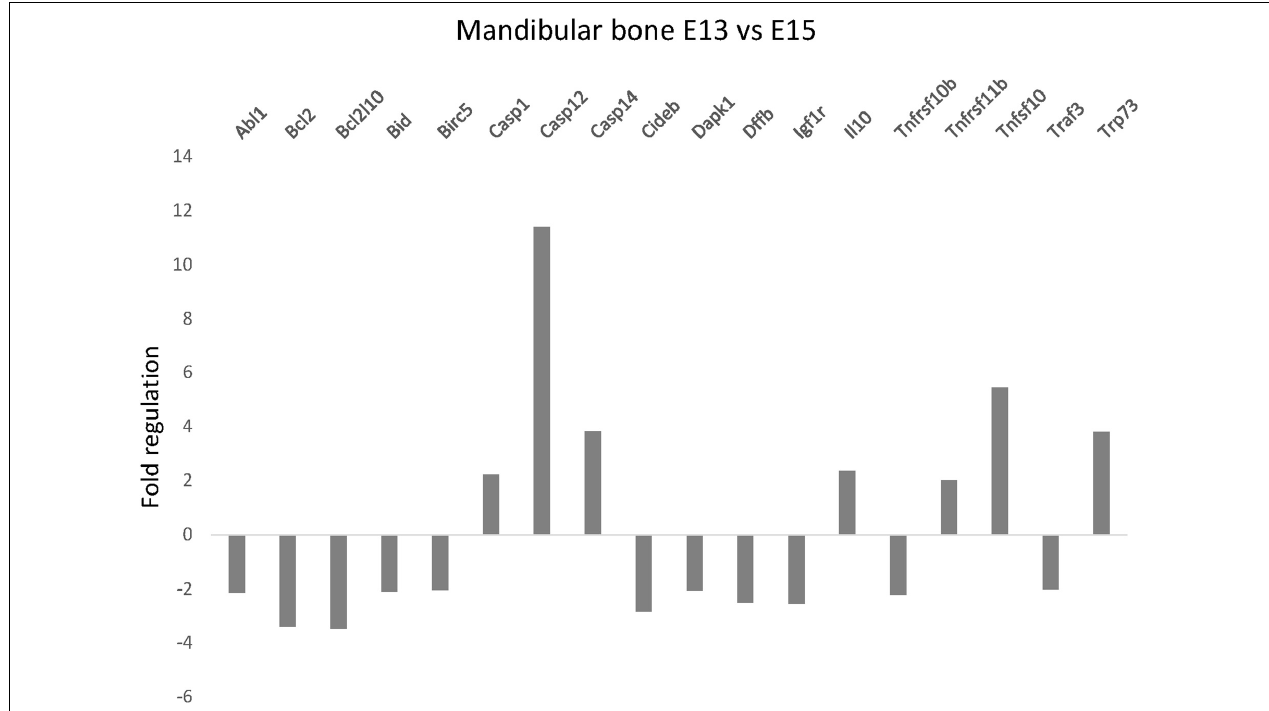
FIGURE 1 | Apoptosis-related gene expression in the developing mandible. Changes in expression of apoptosis-related genes in developing mandibular bone in the mouse. Analysis shows fold regulations (–2/+2 is used as the threshold) of gene expression between the prenatal/embryonic (E) days 13 and 15 detected by PCR Array. Statistically significant ( P < 0.05) changes are